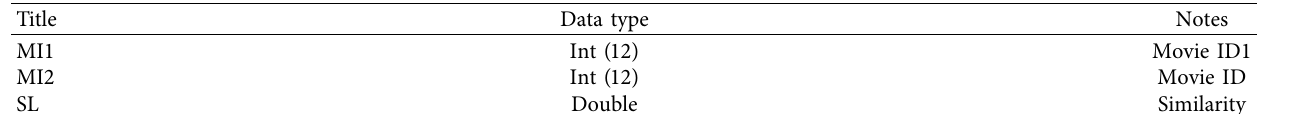
Table 5: Similarity database.